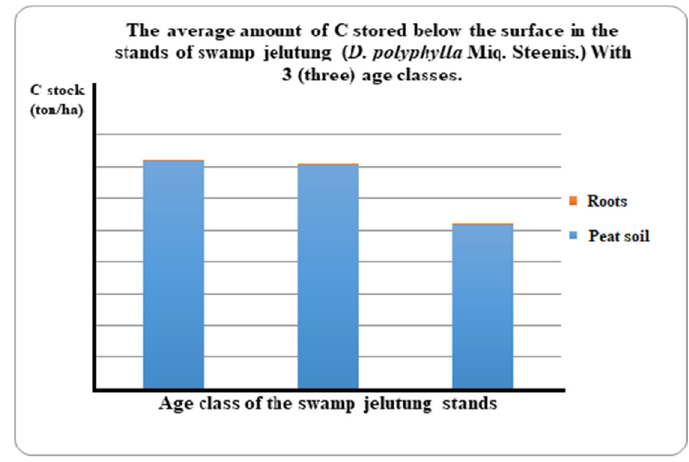
Figure 5. The average amounts of C stored in each constituent component belowground in D. poly- phylla stands with three age classes. D. polyphylla stands with three age classes.